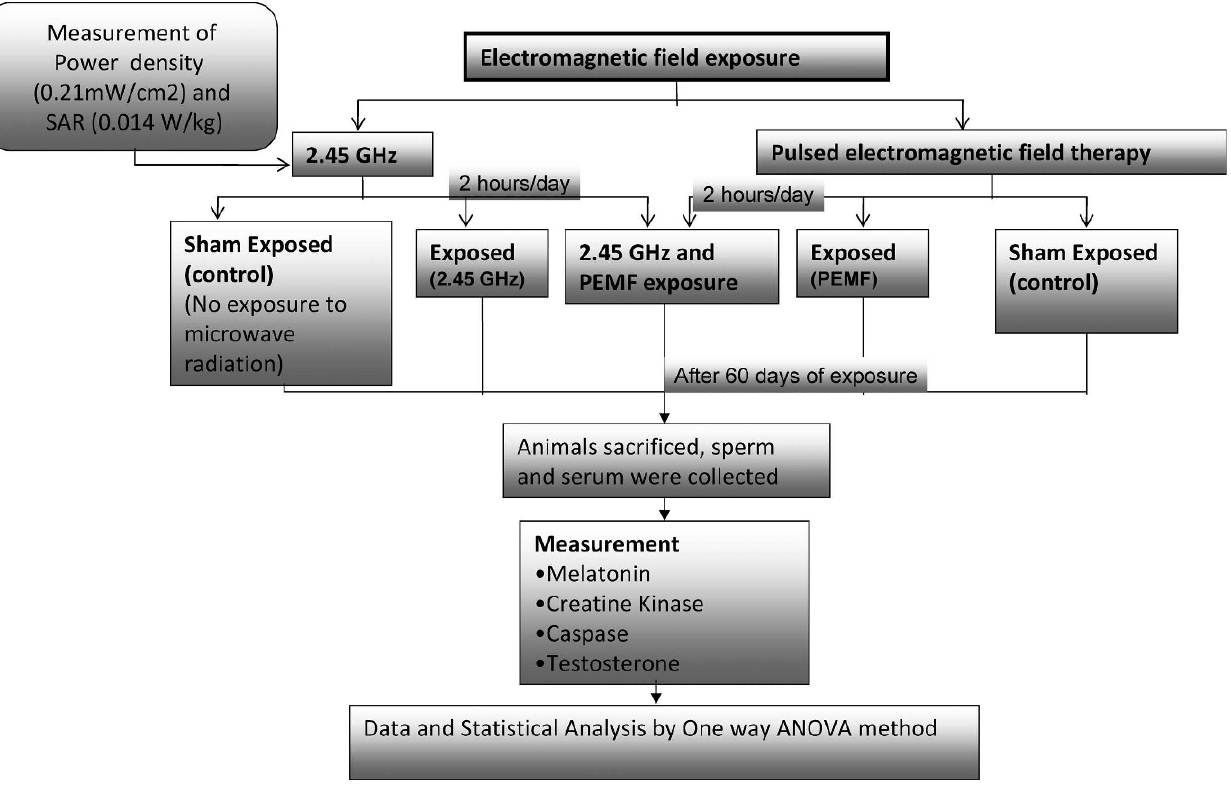
Figure 1 - Assay design for our